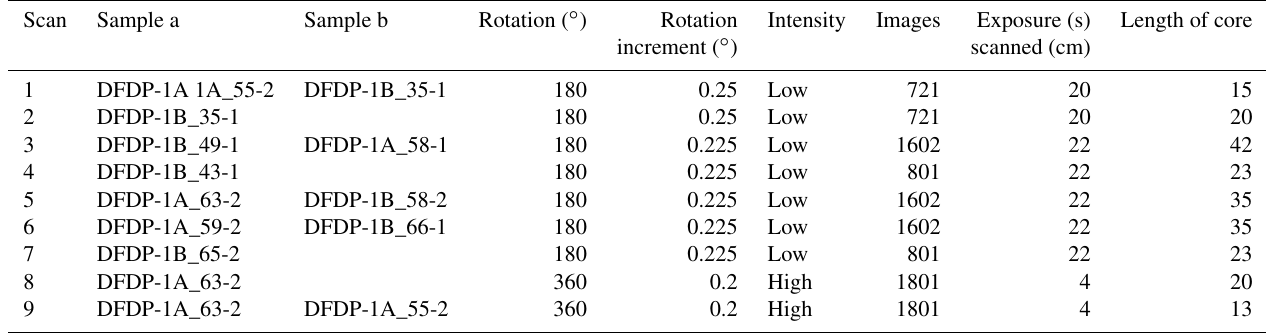
Table 1. Summary of core samples and acquisition parameters for the NT scans performed on DFDP-1 core on the NT instrument DINGO at ANSTO.